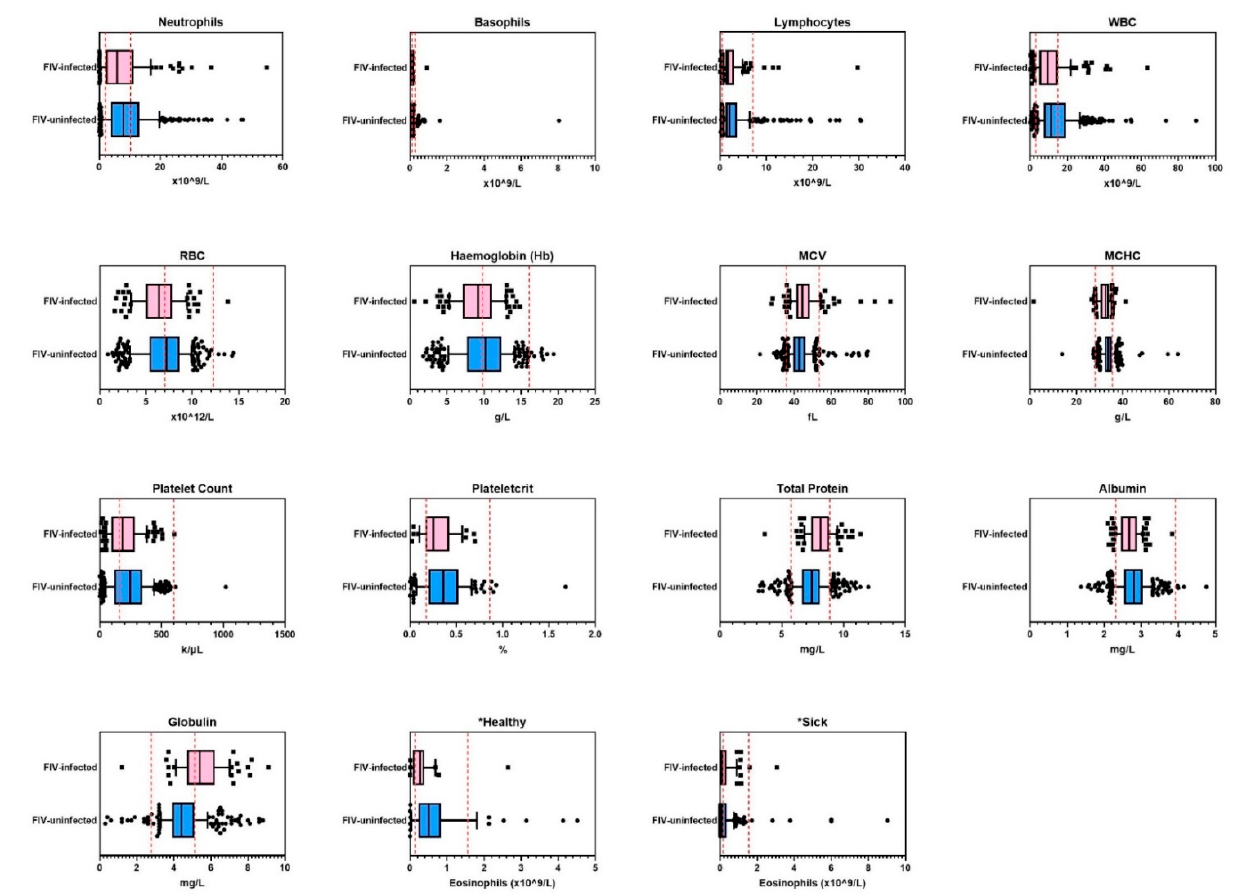
Figure 1. Hematology and blood biochemistry results in cohort 1 ( n = 525; in-house hematology and blood biochemistry testing) from 15 of 37 measurements that were significantly different between FIV-infected and FIV-uninfected cats. Reference intervals are shown as vertical dashed red lines. WBC = white blood cell count, RBC = red blood cell count, MCV = mean corpuscular volume, MCHC = mean corpuscular hemoglobin concentration, HCT = hematocrit.